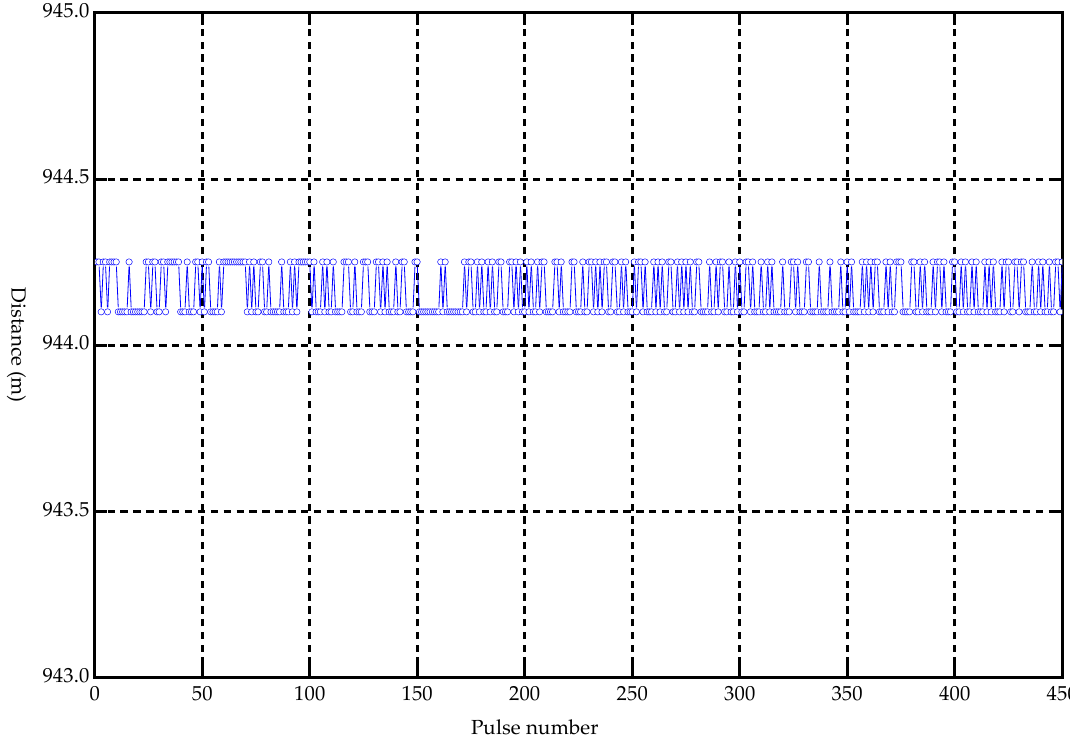
Figure 7. Corresponding distance measurement error.